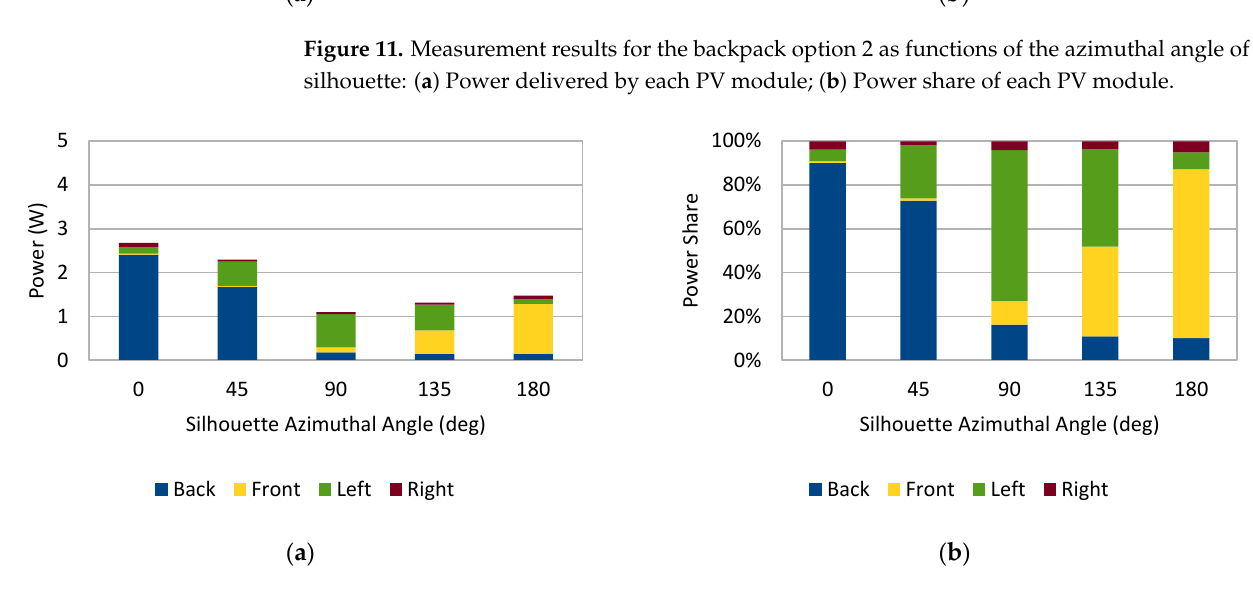
Figure 12. Measurements results for the jacket as functions of the azimuthal angle of the silhouette: ( a ) Power delivered by each PV module; ( b ) Power share of each PV module.